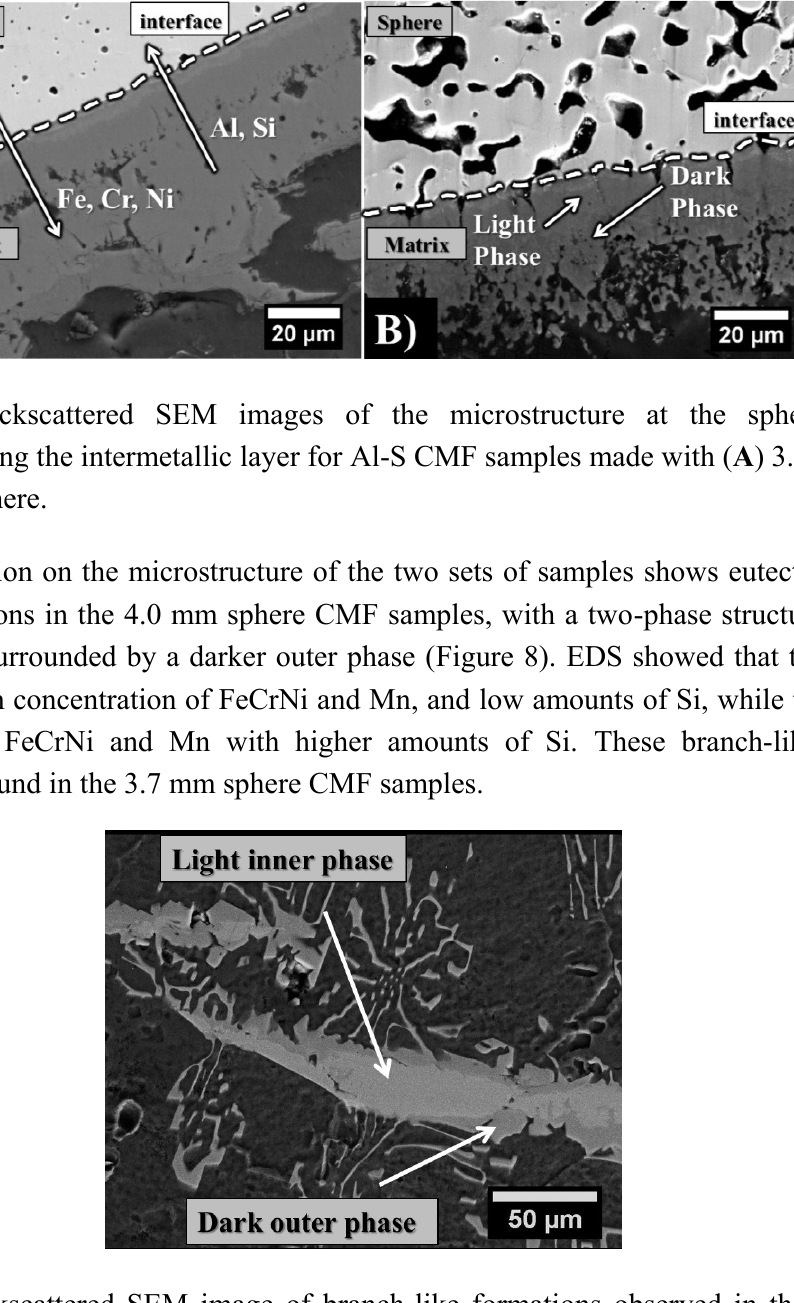
Figure 8. Backscattered SEM image of branch-like formations observed in the 4.0 mm sphere CMF